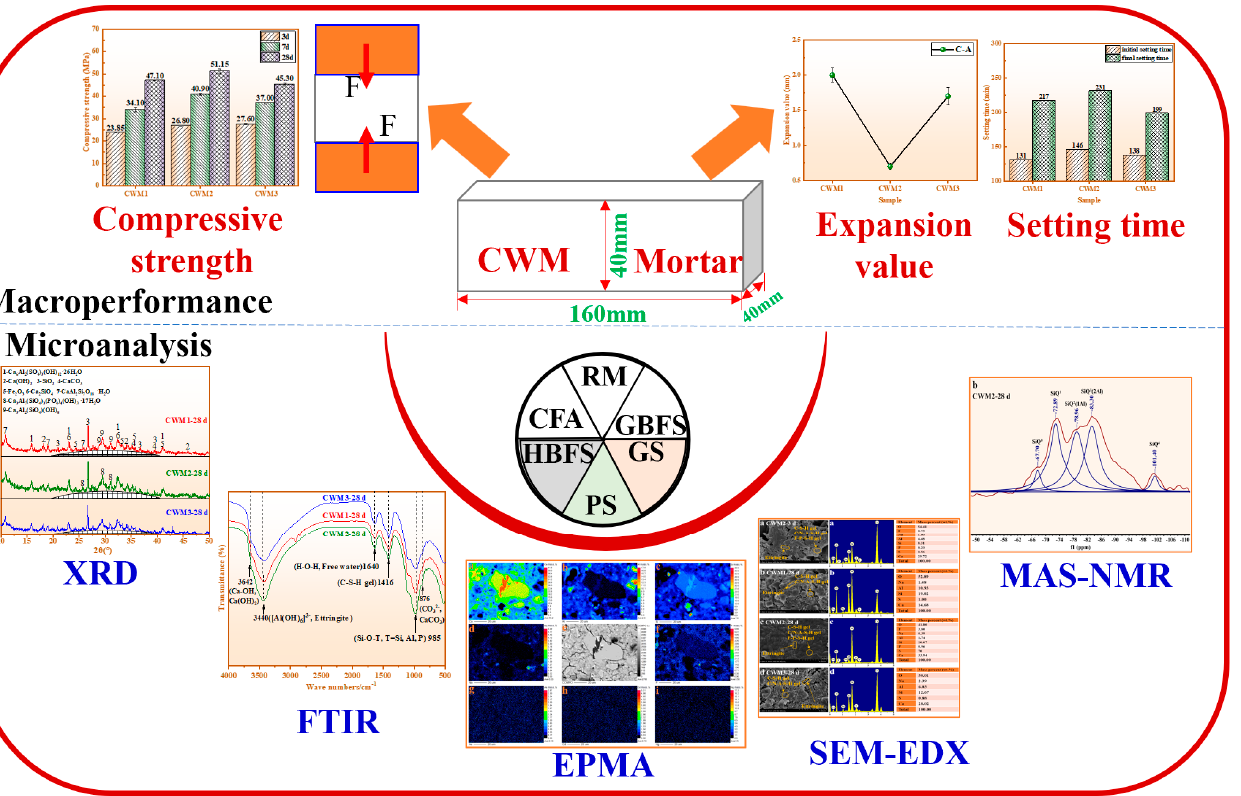
Figure 3. Based on the dosage of the raw materials shown in Table 2, CWM (40 × 40 × 160 mm 3 ) was prepared. The raw material and sand are mixed in a mass ratio of 1:3 in the mortar making process. Then, the CWM mortar was cured in a standard curing box with a temperature of 20 ± 1 ◦ C and a relative humidity of 95 ± 1%. Then, the strength value of the CWM was evaluated on the press display. The setting times and volume expansion were checked according to GB 175–2007 [22]. CWM pastes were prepared to detect the microscopic characteristics (XRD, FTIR, MAS-NMR, SEM-EDX, and EPMA).